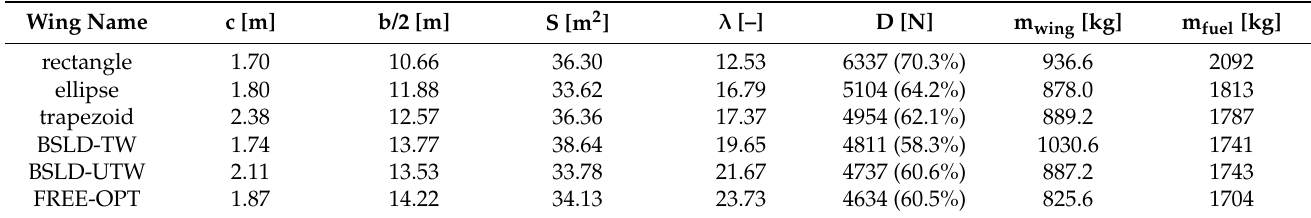
Table 3. Summary of geometrical, aerodynamic, and mass characteristics of wings.